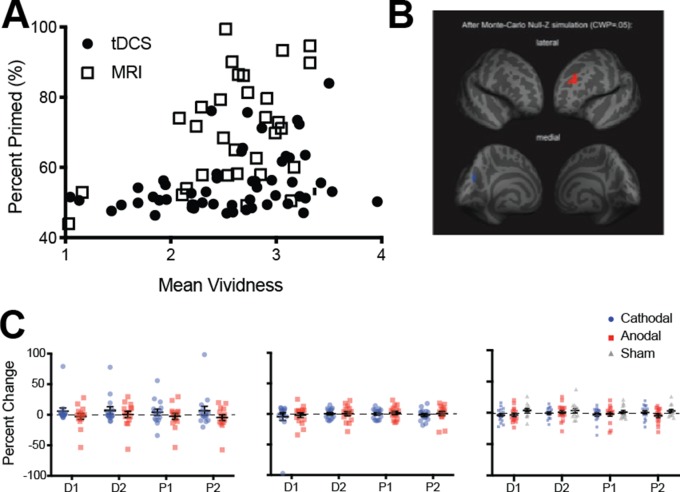
Imagery vividness results.(A) Data shows the correlation between mean vividness ratings (x-axis) and visual imagery priming (y-axis) for participants from both the MRI and tDCS experiments (tDCS experiments 2, 3 and 4). All possible participants’ data were included for the tDCS analysis (resulting in the analysis of 54 participant’s data). Only the correlation in the tDCS sample was significant, (rs = 0.37, p=0.003, Spearman’s rank-order correlation was used due to a violation of normality). The effect size was too small for significant results in the fMRI sample (rs = 0.34, p=0.065, Spearman’s rank-order correlation was used due to a violation of normality, N = 31). (B) Surface-based whole brain analysis of the fMRI resting-state data: associations with subjective vividness. Corrected clusters showing associations with individual subjective vividness at a cluster-wise probability threshold of p<0.05 (see also see Supplemental Table S3). The upper row shows a lateral view of the two hemispheres from an anterior perspective, whereas the lower row shows a medial view of them from the back. Multiple comparison correction was done using Monte Carlo Null-Z simulation (mc-z). No smoothing of the functional data was applied. Only two fMRI mean intensity clusters showed associations with subjective vividness that survived the correction for multiple comparisons: One cluster in the left rostralmiddlefrontal cortex showed a positive association (orange), and one smaller cluster in the left cuneus showed a negative association (blue). Note the similarity in the subjective vividness results with the ones in Bergmann et al. (2016b), where only a volume cluster in left frontal cortex also showed a positive association with subjective vividness. Apparently, the positive relationship of subjective vividness with the anatomy of left frontal cortex is also reflected in the fMRI mean intensity levels of this region. (C) tDCS effect on mean vividness ratings. Left panel: Occipital (1.5ma) – Vividness ratings were included in this experiment, which allowed us to look at subjective changes in imagery vividness that occur with changes in cortical excitability of the visual cortex. Red dots show the effect of anodal stimulation (increasing excitability) while blue dots show cathodal stimulation (decreasing excitability). Each dot represents an individual participant (one participant’s data is excluded from this analysis due to incorrect button presses on one of the days of testing, N = 15). All data show means and error bars represent ± SEM’s. The data was again analyzed using percentage changed. We found no significant differences in the reported mean vividness of the imagined patterns (main effect of tDCS polarity: F(1,14) = 1.97, p=0.18, main effect of block: F(3,42) = .73, p=0.54, interaction: F(3,42) = .59, p=0.63). Middle panel: tDCS of prefrontal cortex and mean vividness ratings. As vividness ratings were included in this experiment, we could also look at the subjective changes in imagery vividness that occur with changes in cortical excitability of the prefrontal cortex. Red dots show the effect of anodal stimulation (increasing excitability) while blue dots show cathodal stimulation (decreasing excitability). All data show means and error bars represent ± SEM’s. We again analyzed the data using the percent change scores. There were no differences in the mean vividness ratings for either polarity of the tDCS (main effect: F(1,15) = .28, p=0.61) or the block (main effect: F(3,45) = .77, p=0.51), and there was no interaction between the two (F(3,45) = .07, p=0.98). Right panel: tDCS of occipital cortex (1.5ma) – cathodal, anodal and sham stimulation, one participant's data is removed due to incorrect button presses for vividness ratings. Red dots show the effect of anodal stimulation (increasing excitability) while blue dots show cathodal stimulation (decreasing excitability), and grey triangles show the effect of sham stimulation. All data show means and error bars represent ± SEM’s. We again analyzed the data using the percent change scores. There were no differences in the mean vividness ratings for any of the polarity conditions (Mixed-effects analysis due to attrition: Polarity effect: F(1.95, 31.19)=1.38, p=0.27), there was also no effect of block (F(2.19, 34.98)=0.94, p=0.41) and no interaction (F(2.63, 36.82)=0.98, p=0.41).